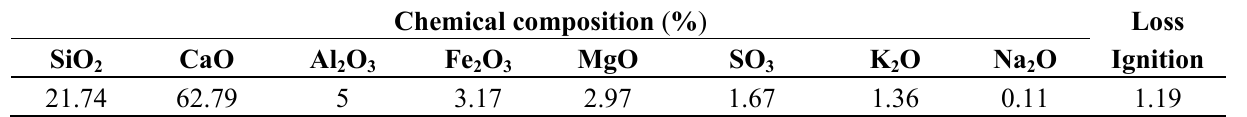
Table 1. Chemical composition of Type I Ordinary Portland